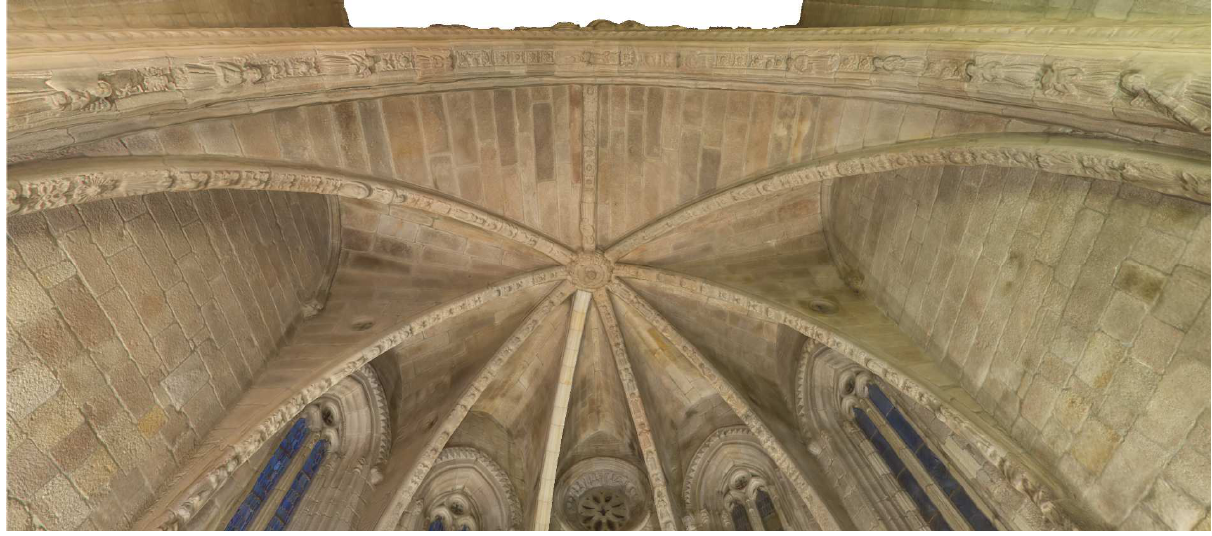
Figure 7. High resolution model. Level of detail view.